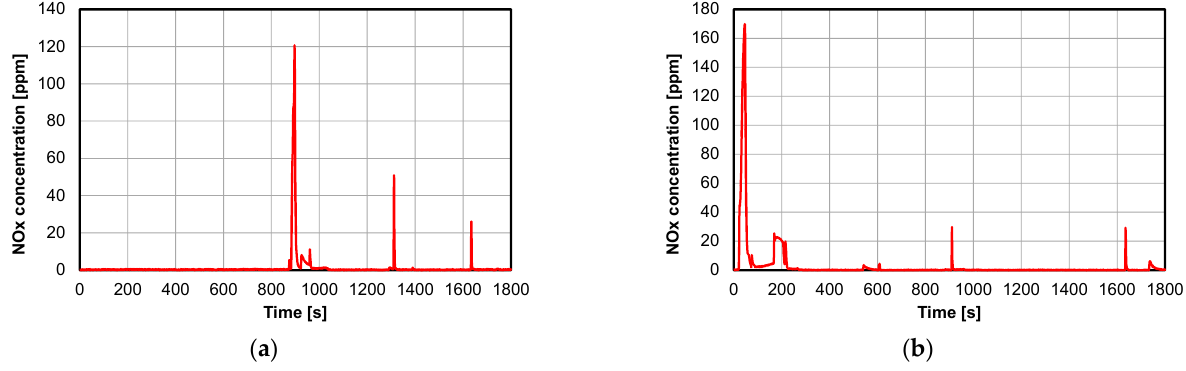
Figure 13. The NO x concentration versus time for: ( a ) plug-in; ( b ) HEV.